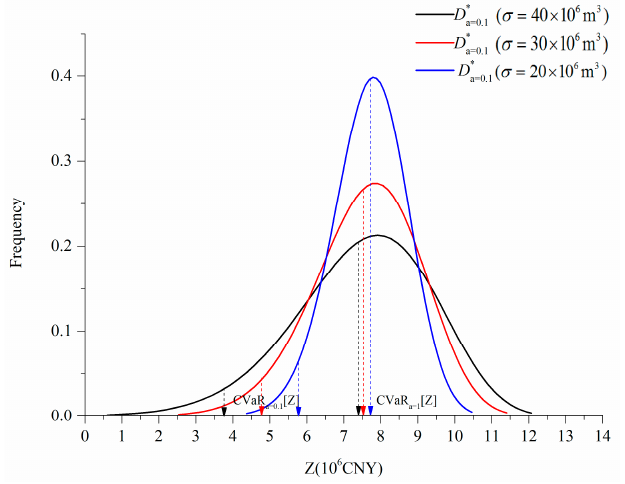
Figure 6. Probability density functions of Z under different values of σ ( 0.1 α= ).